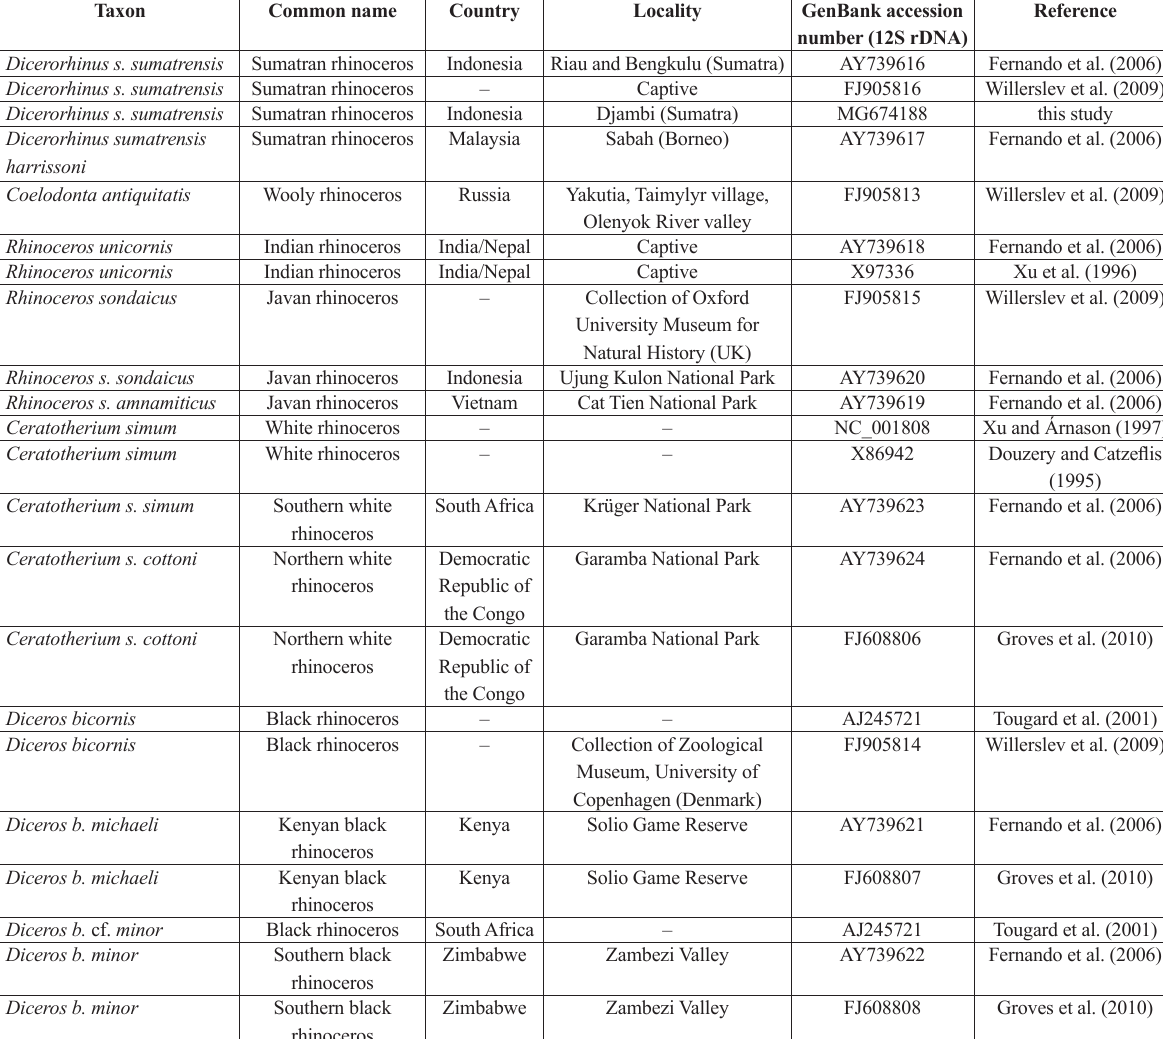
Table 1. Locality data and GenBank accession numbers for Rhinocerotidae 12S rDNA sequences used in this